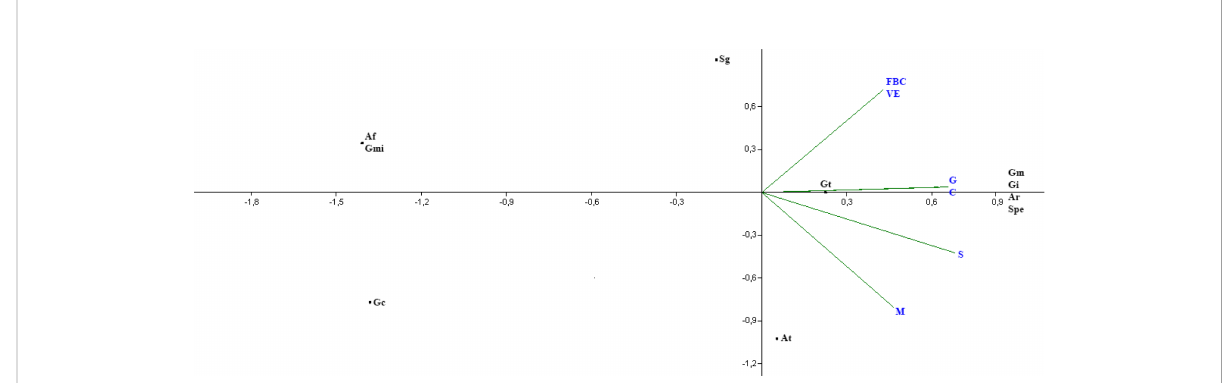
FIGURE 2 Analysis of principal components of the frequency of arbuscular mycorrhizal fungi species found in the rhizosphere of crotalaria (C), wild bean from Ceara ́ (FBC), sorghum (S), Guandu ́ (G), millet (M) and spontaneous vegetation (VE). (Af, A. foveata ; At, A. tuberculata ; Ar, Ar. leptoticha ; Ge, G. etunicatum ; Gm, G. macrocarpum ; Gmi, G. microaggregatum ; Gt, G. tortuosum ; Gi, Gigaspora sp.; Sg, S. gregaria ; Spe, S. persica